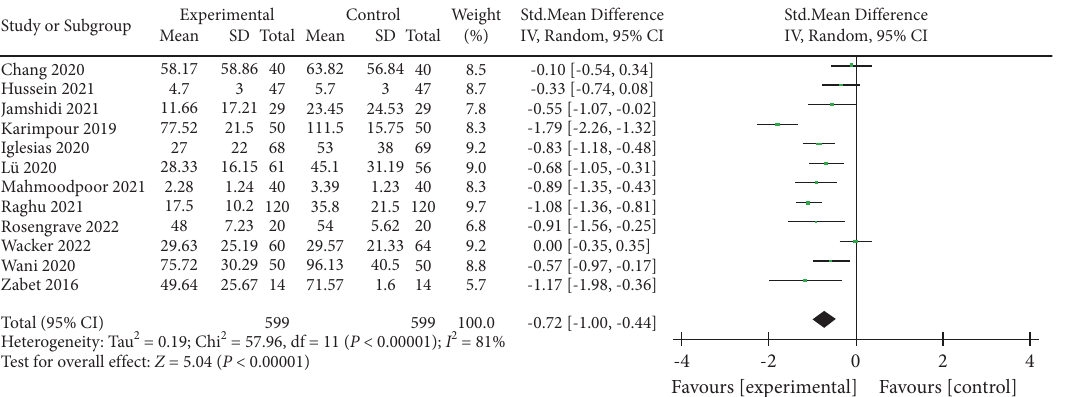
Figure 13: Forest plots for the efect of vitamin C on the duration of vasopressors.